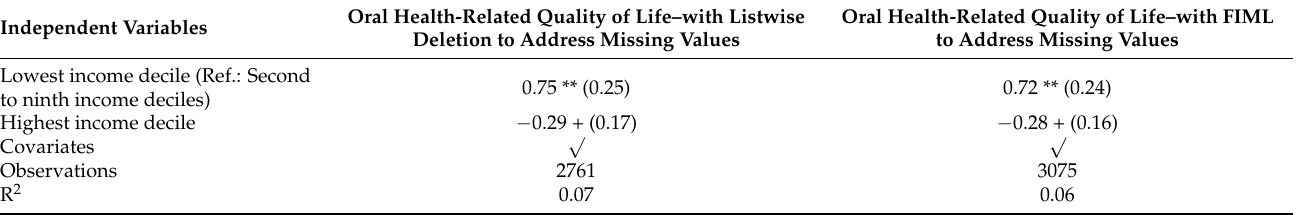
Table 3. Determinants of oral health-related quality of life. Results of multiple linear